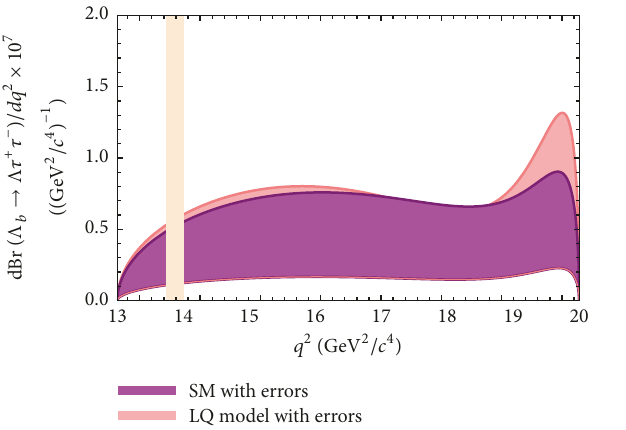
Figure 3: The dependence of the differential branching ratio on 𝑞 2 for the Σ → Σ𝜇 + 𝜇 − transition in the SM and LQ models. The 𝑏 vertical shaded bands indicate the charmonia veto regions.